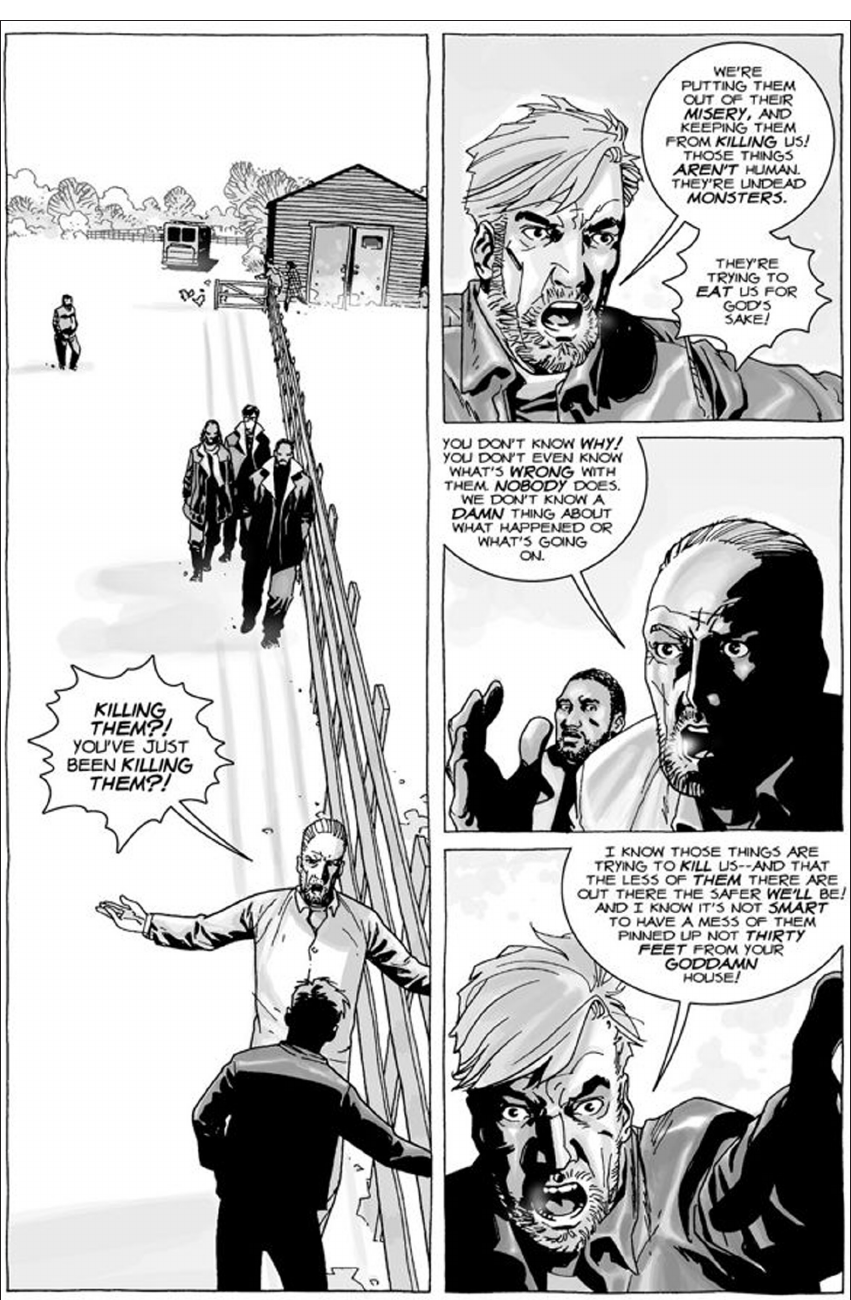
Figure 1: Kirkman, Robert (w) Tony Moore (a) and Charlie Adlard (a). Page from Kirkman, R. 2006. The Walking Dead : Book 1. © 2006 Image